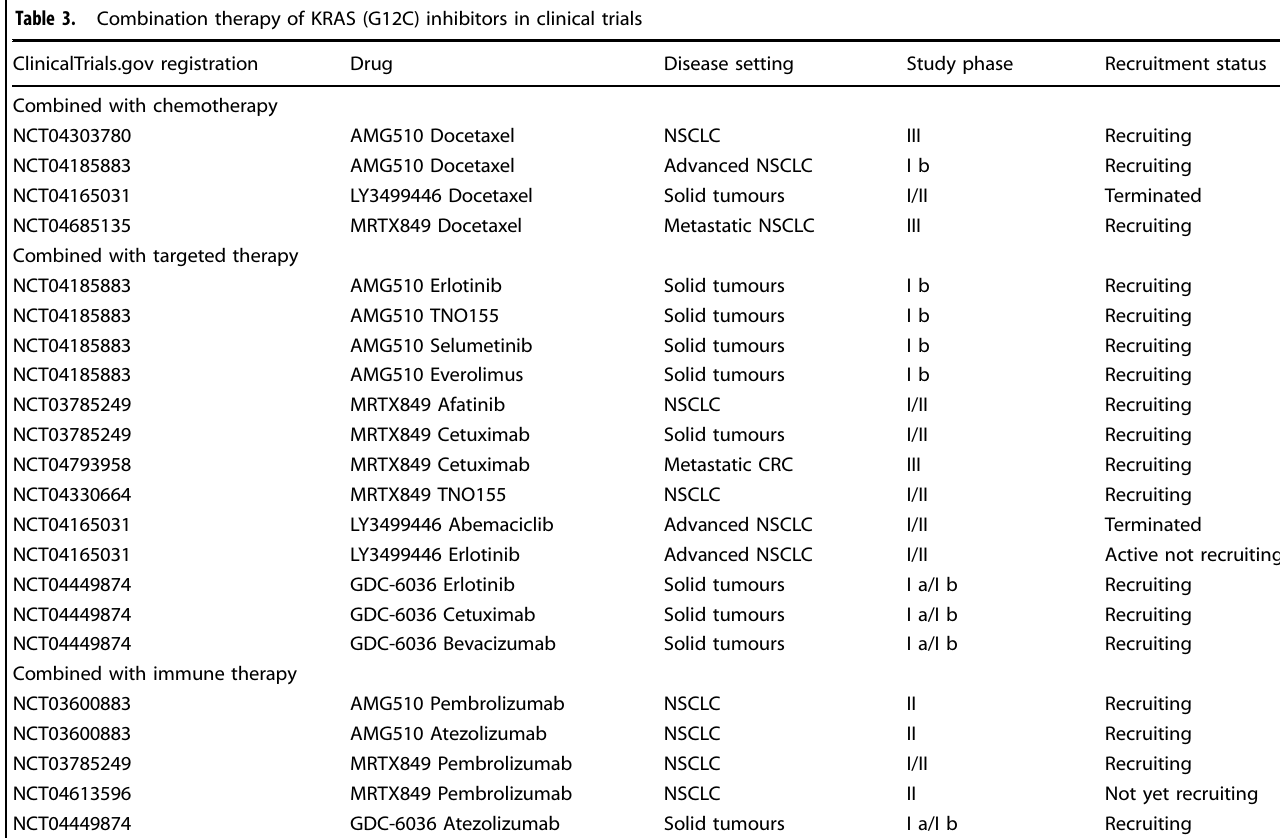
Table 3. Combination therapy of KRAS (G12C) inhibitors in clinical trials ClinicalTrials.gov